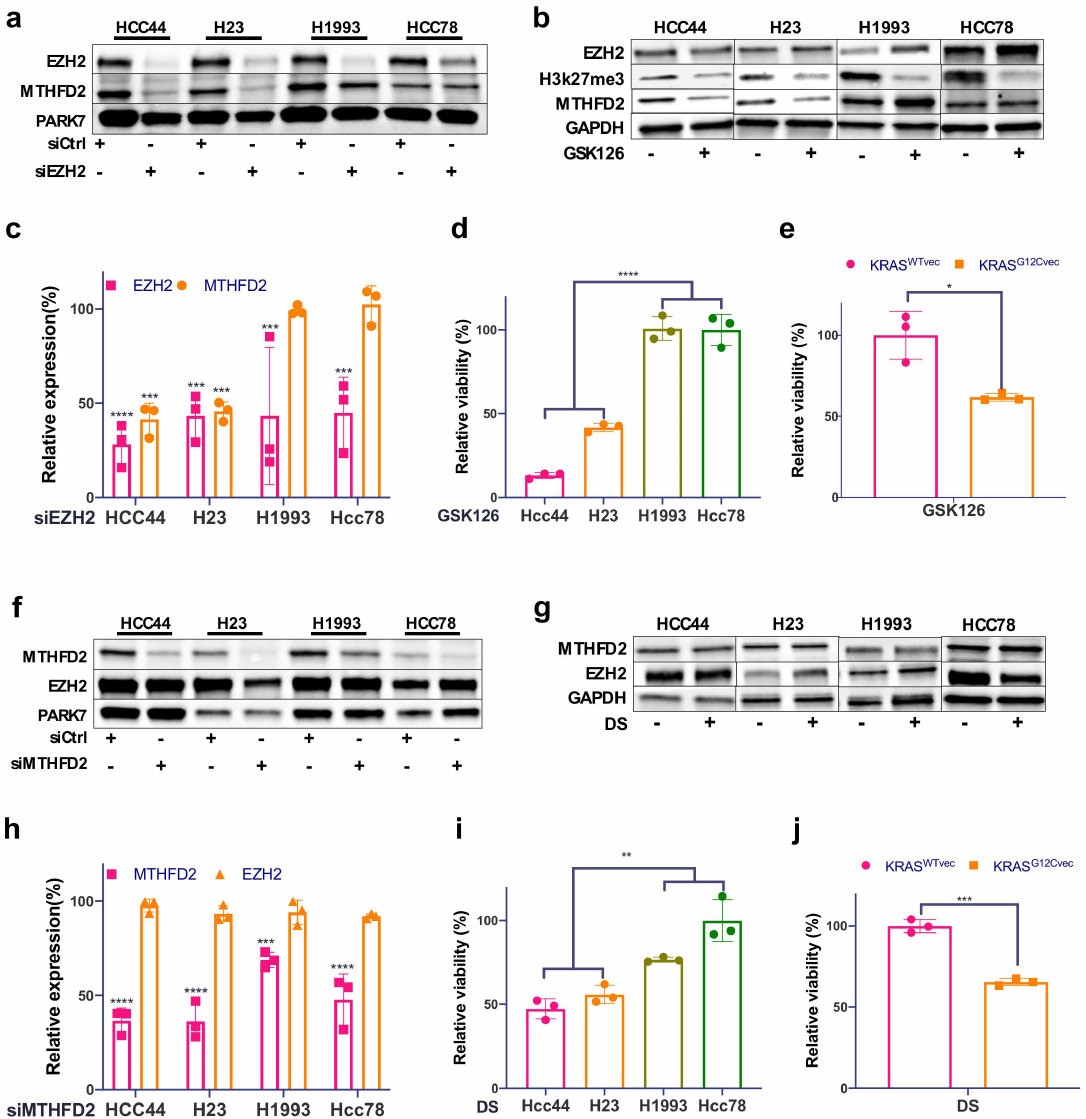
Figure 3. MTHFD2 expression is dependent on EZH2 in KRAS G12C cell lines. ( a ) Western blot analysis of EZH2 and MTHFD2 in the four AC cell lines HCC44, H23, H1993, and HCC78 after EZH2 siRNA knockdown and ( b ) after 48 h treatment with the EZH2 inhibitor GSK126 (5 µ M). ( c ) Related quantification of EZH2 and MTHFD2 protein expression after EZH2 knockdown. ( d ) The cellular survival of the four described cell lines treated as in ( b ). ( e ) The cellular survival of KRAS WT - and KRAS G12C -transfected H1993 cells after 48h treatment with GSK126 (5 µ M). ( f ) Western blot analysis of EZH2 and MTHFD2 in the four AC cell lines after MTHFD2 siRNA knockdown and ( g ) after 48 h treatment with the MTHFD2 inhibitor DS (20 µ M). ( h ) Related quantification of EZH2 and MTHFD2 protein expression after MTHFD2 knockdown. ( i ) The cellular survival of the four described cell lines treated as in ( g ). ( j ) The cellular survival of KRAS WTvec and KRAS G12Cvec H1993 cells after 48 h treatment with DS (20 µ M). (* p < 0.05, ** p < 0.01, *** p < 0.001, **** p <